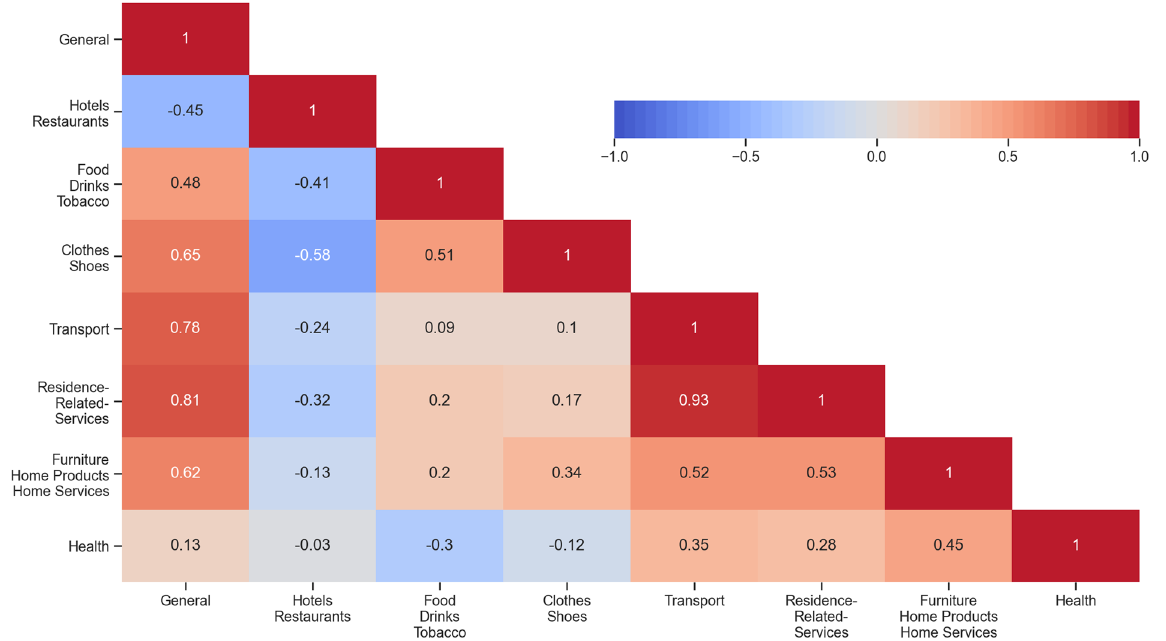
Fig. 2 Correlations between the CPIs of different industries. The darker the color, the stronger the